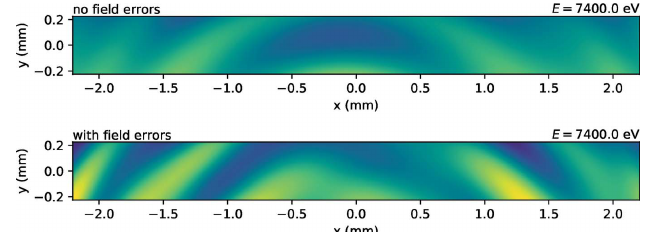
Figure 4 Calculated transverse intensity distribution at the front-end movable mask at ca 18 m from the source. The e-beam was tilted by (cid:6) 80 m rad (typical operational tilt) and the taper was set to 0.25 mm (typical operational taper). The field of view corresponds to 250 m rad (h) (cid:3) 25 m rad (v). The color map range is common for both cases. An animated version of the figure can be found in the supporting